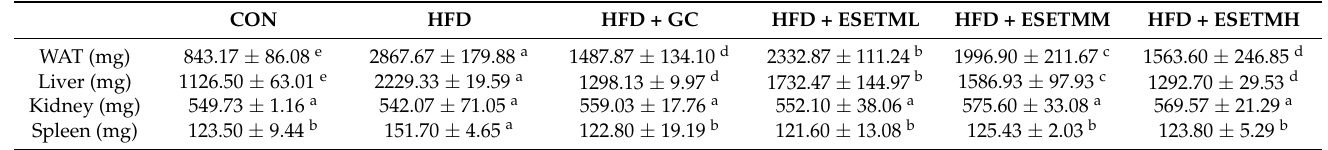
Table 2. Oran weights in ICR mice with